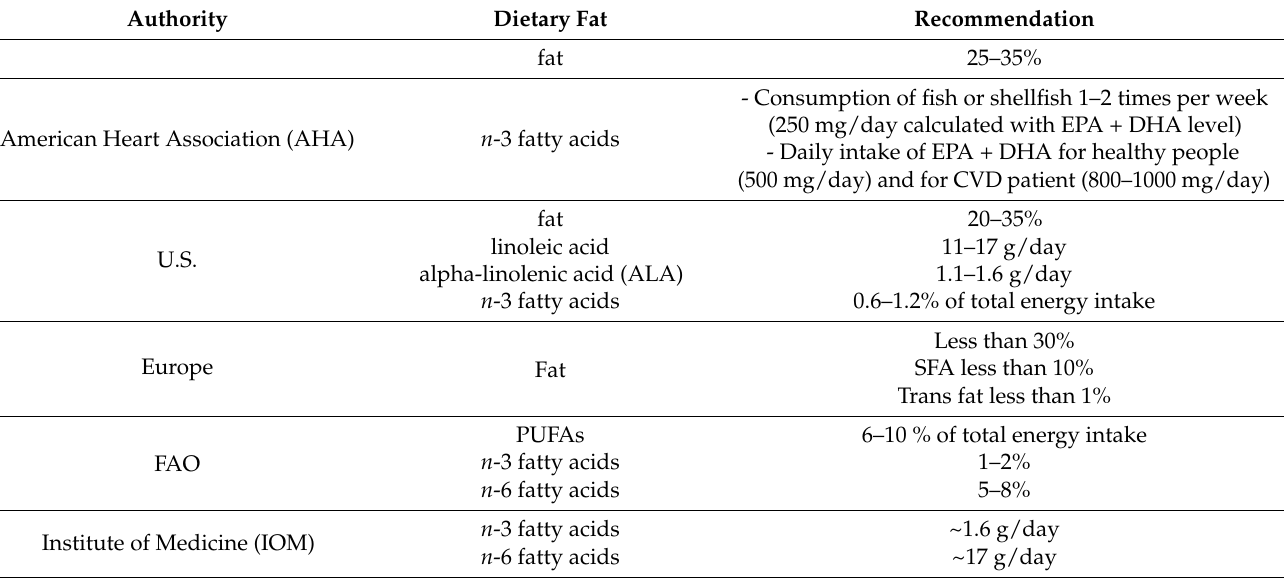
Table 4. Recommendations for the dietary n -3